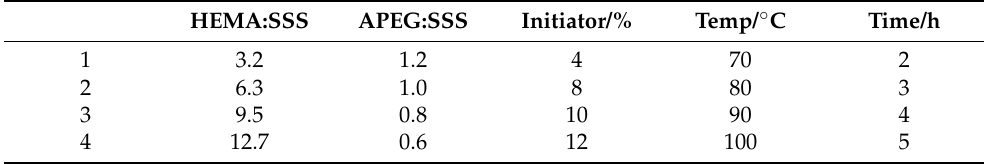
Table 1. Levels and factors of L 16 (4 5 ) orthogonal experiments.